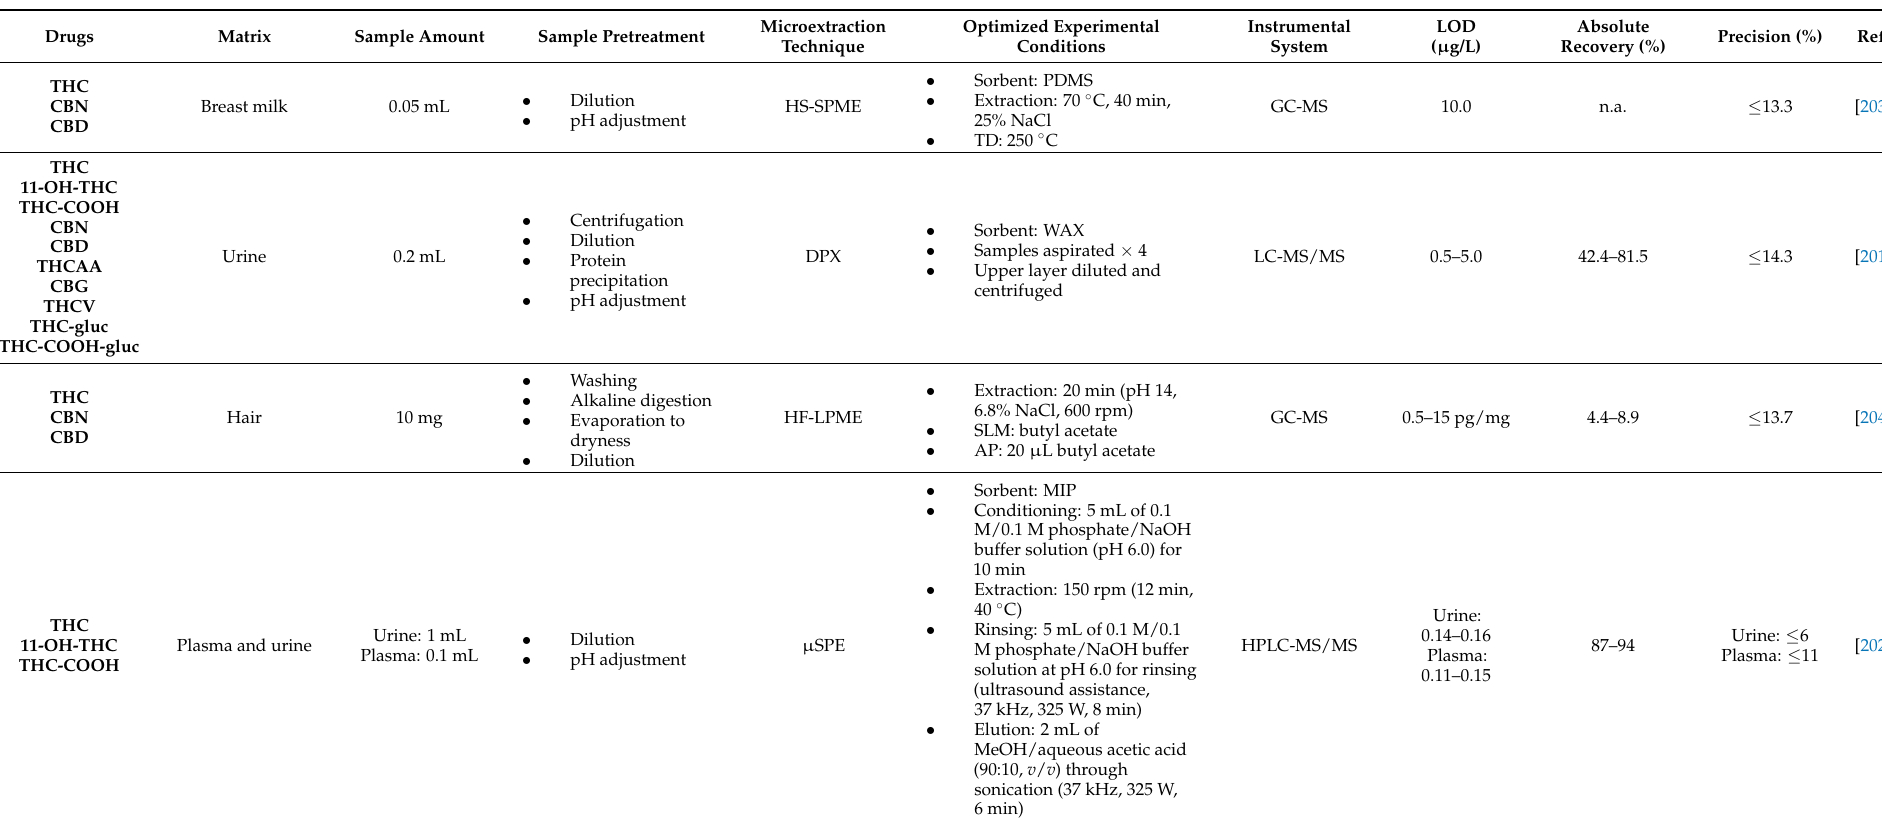
Table 4. Microextraction-based approaches for the analysis of cannabinoids and related substances in the forensic